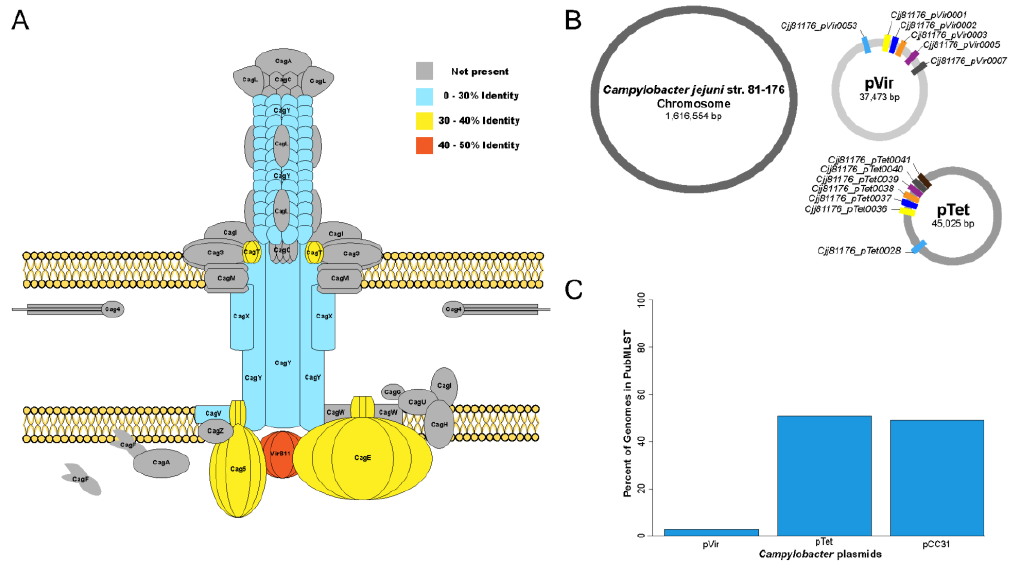
Figure 5. Components of the type IV secretion system (T4SS) identified in C. jejuni . Panels: ( A ) Identification of C. jejuni homologs to the structural components of the H. pylori Cag T4SS. Colors represent the percentage of protein identity for those proteins present as indicated in the figure legend. ( B ) Identification of potential T4SS genes in C. jejuni str. 81-176 genome that is represented by the chromosome, pVir and pTet; identical colors on pVir and pTet represent T4SS genes that encode for the same T4SS structural component, whereas different colors encode for T4SS structural genes unique to that particular plasmid. ( C ) Percentage of the >54,000 genomes in the PubMLST database that contain at least 2000 bp of the Campylobacter plasmid (pVir, pTet, or pCC31) that potentially encodes T4SS structural components.